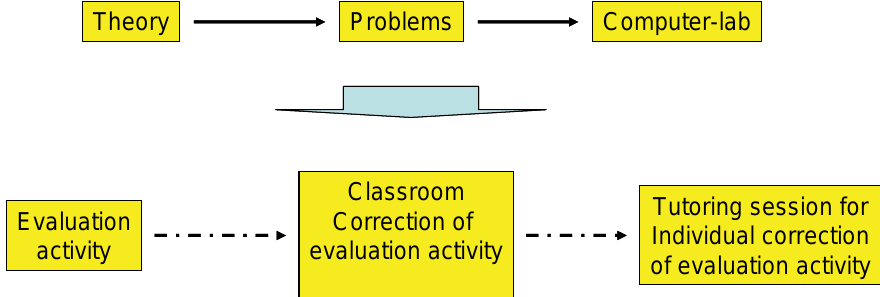
Fig. 5: Activities reassignment for the evaluation/assessment